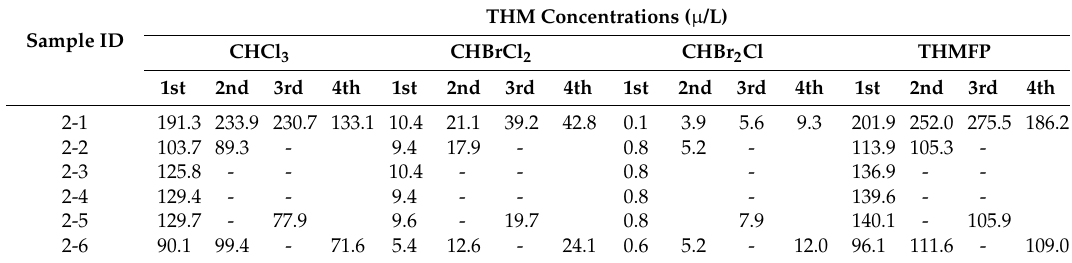
Table 5. THM formation potential and major THM species in the selected samples of System